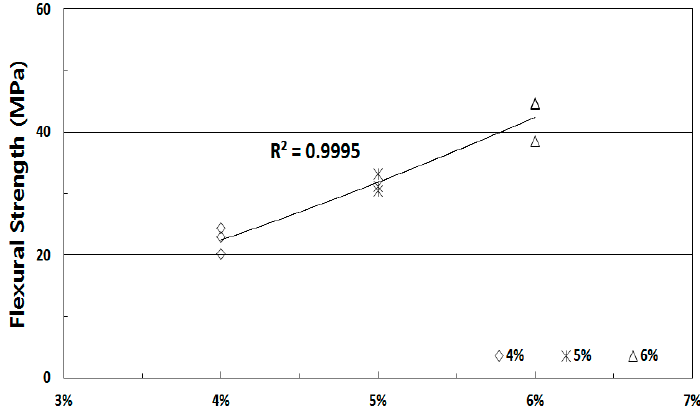
Figure 6. Test results of flexural strength with respect to fiber volume fraction.